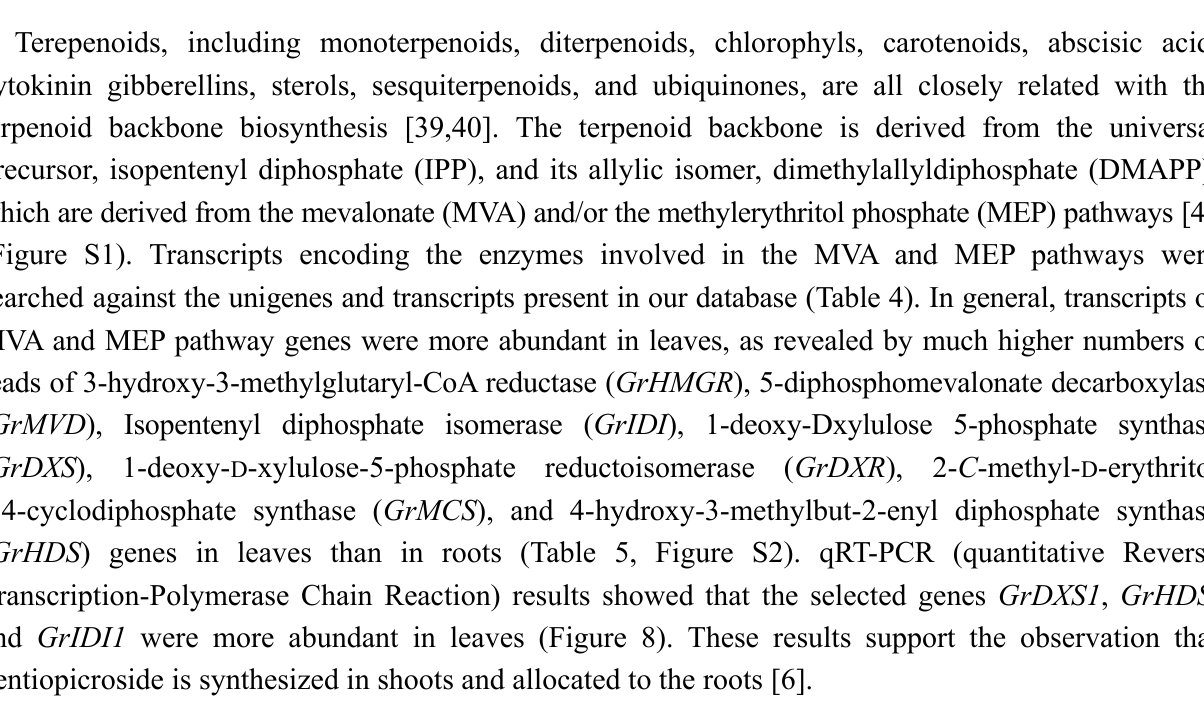
Table 4. Expression of putative genes in MVA and MEP biosynthesis pathways.